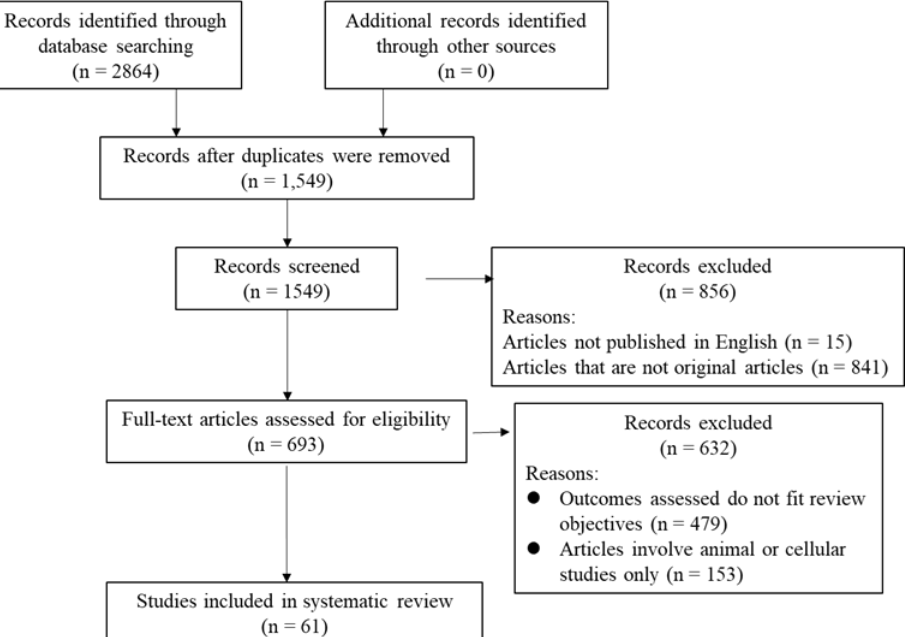
Figure 1. The PRISMA flow diagram.